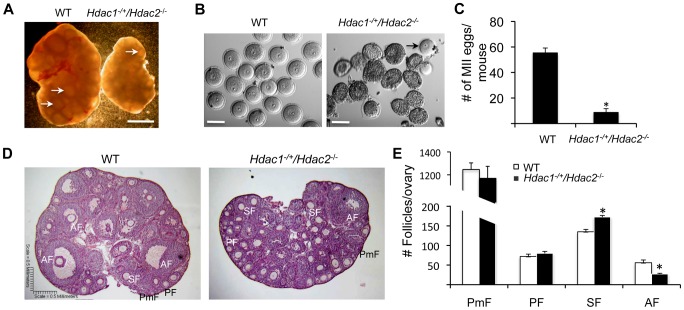
Decreased ovary size and defective oogenesis following specific targeting of Hdac2 and reduction of Hdac1 in oocytes.(A) Ovary morphology from WT and Hdac1−/+/Hdac2
−/− mice 6 weeks-of-age. WT ovary shows presence of mature follicles (arrows), whereas fewer of such follicles are present in Hdac1−/+/Hdac2
−/− mice. The bar corresponds to 1 mm. (B) Full-grown oocytes are recovered from WT mice, whereas increased number of immature follicles and only a few oocytes are recovered from Hdac1−/+/Hdac2
−/− mice. The bar corresponds to 100 µm. The arrow points to an oocyte that is nearly full-grown. (C) Fewer eggs are ovulated from Hdac1−/+/Hdac2
−/− mice after hormonal stimulation. WT and Hdac1−/+/Hdac2
−/− 6-week-old females were superovulated with an intraperitoneal injection of 5 I.U eCG followed by administration of 5 I.U. hCG 48 h later. At least 10 mice from each genotype were used, and the average number of ovulated oocytes per female is indicated. * P<0.05. (D) Histological analysis of ovaries obtained from WT and Hdac1−/+/Hdac2
−/− mice18 days-of-age. Primordial (PmF), primary (PF), secondary (SF), and antral follicles (AF) are indicated. The bar corresponds to 0.5 mm. (E) Follicle counts from ovaries obtained from WT and Hdac1−/+/Hdac2
−/− mice 18 days-of-age. Data are from 3 different ovaries and are presented as mean ± SEM. * P<0.05.